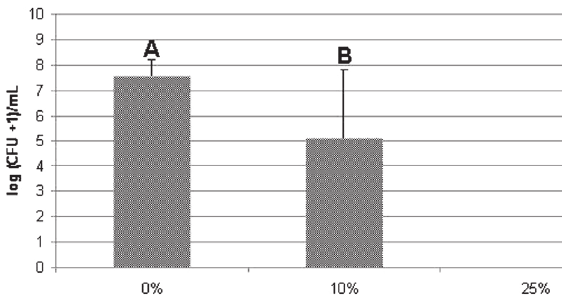
Figure 2 - Effect of different percentages of poly(2-tert- butylaminoethyl) methacrylate (PTBAEMA) incorporated into acrylic resin specimens on the viability of Streptococcus mutans biofilm cells. Error bars represent standard deviations ( α =0.05). Different capital letters denote significant differences among groups (Mann- Whitney test, p =0.001)